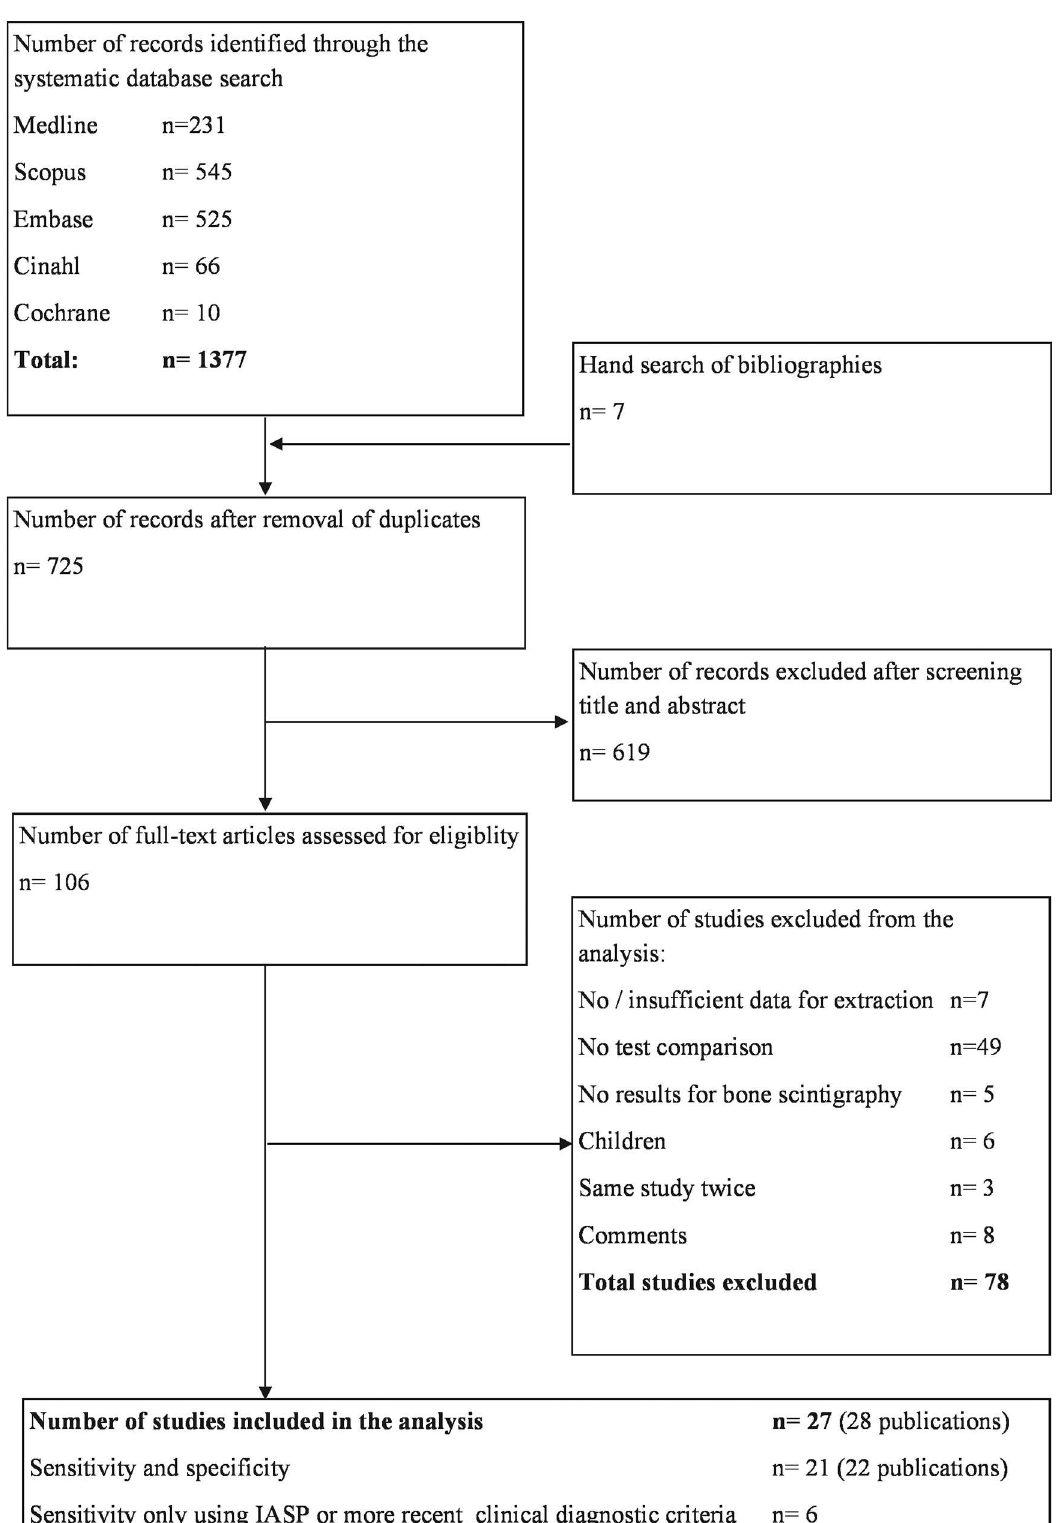
Fig 1. Study Flow.